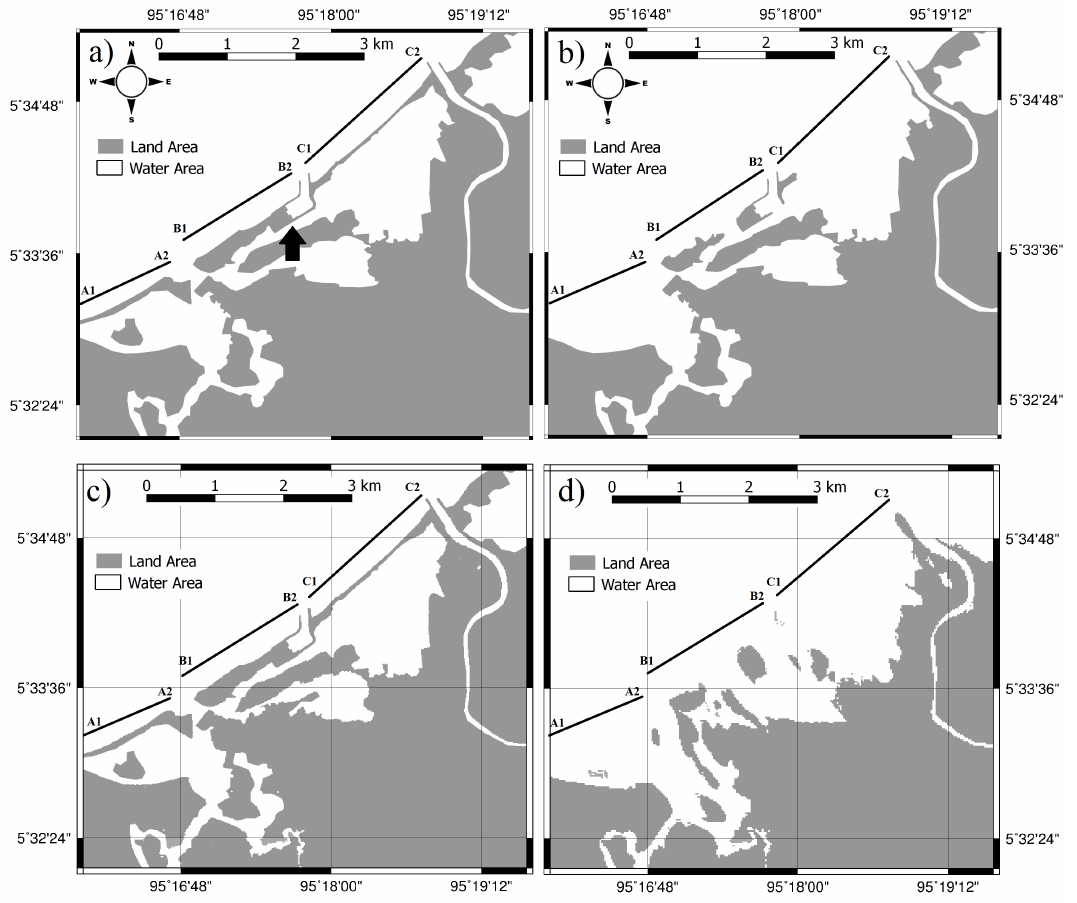
Figure 10. Coastal area comparison between the satellite images: ( a ) before, ( b ) after the tsunami in 2004 and numerical simulation: ( c ) before simulated and ( d ) after simulated by COMCOT-SED. The satellite images are taken from Google Earth with time history imagery setting on 23 July 2004 and 28 January